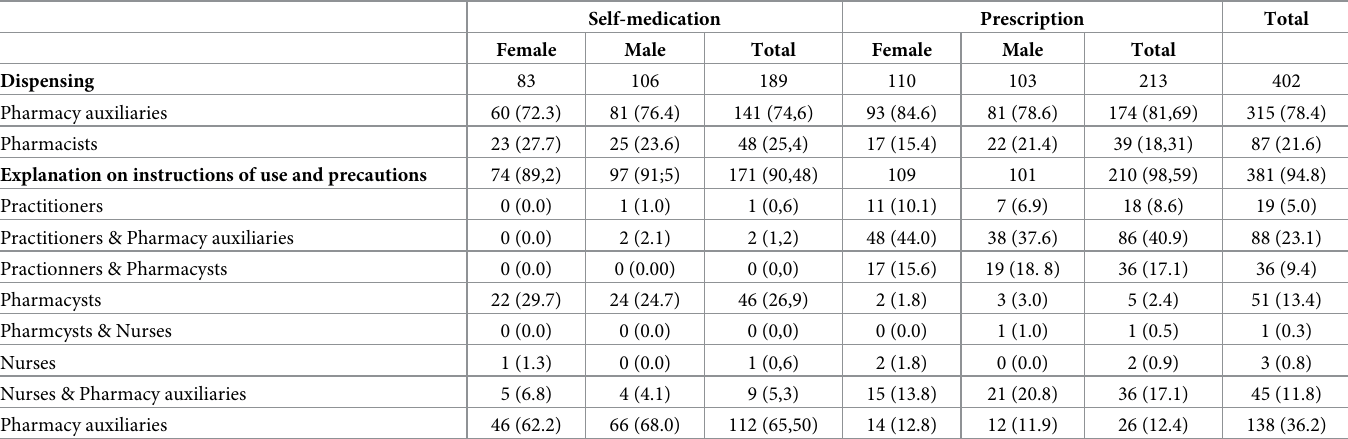
Table 4. Dispensing practices in the